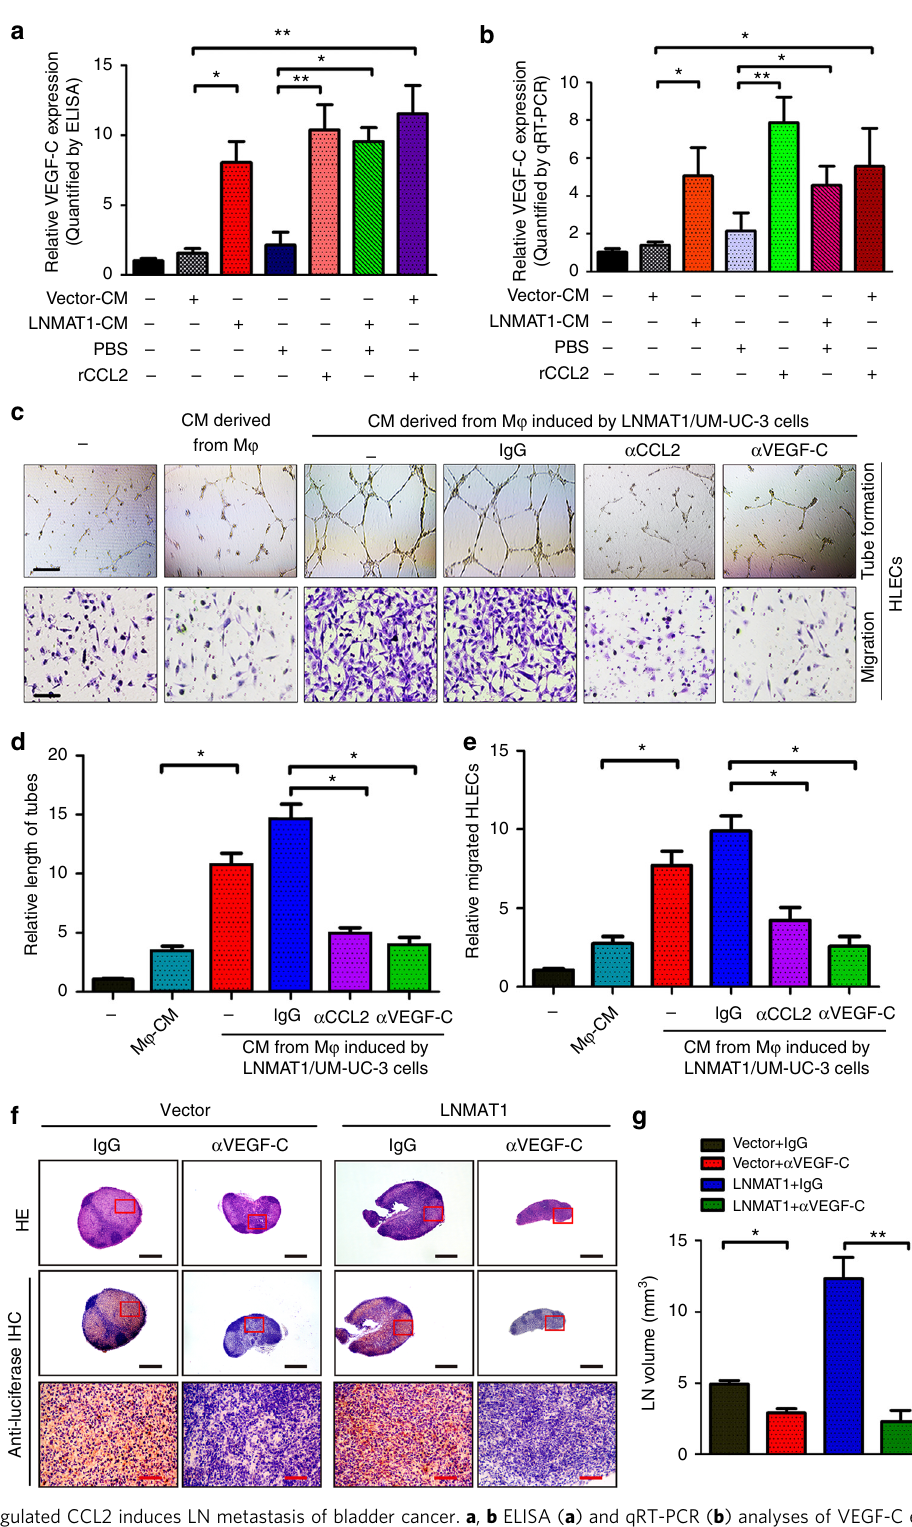
Fig. 8 LNMAT1 -upregulated CCL2 induces LN metastasis of bladder cancer. a , b ELISA ( a ) and qRT-PCR ( b ) analyses of VEGF-C expression in TAM-like macrophages induced by conditioned medium collected from the indicated cells. One-way ANOVA followed by Dunnett ’ s tests for multiple comparison. c – e Representative images ( c ) and quanti fi cations ( d , e ) of tube formation and Transwell migration by HLECs treated with conditioned medium collected from macrophages induced by LNMAT1 from UM-UC-3 cells. HLECs were cultured with conditioned medium derived from TAM-like macrophages induced by the indicated cancer cells. Scale bars: 100 µ m. Two-tailed t -tests and one-way analyses of variance (ANOVA) followed by Dunnett ’ s tests for multiple comparison. f Representative images of HE and IHC staining con fi rming the LN status ( n = 16). Scale bars: black, 500 µ m; red, 100 µ m. g Volume quanti fi cation of popliteal LN metastasis after inhibition of VEGF-C with neutralizing antibody. Two-tailed t -tests. The error bars represent standard deviations of three independent experiments. * p < 0.05 and ** p <